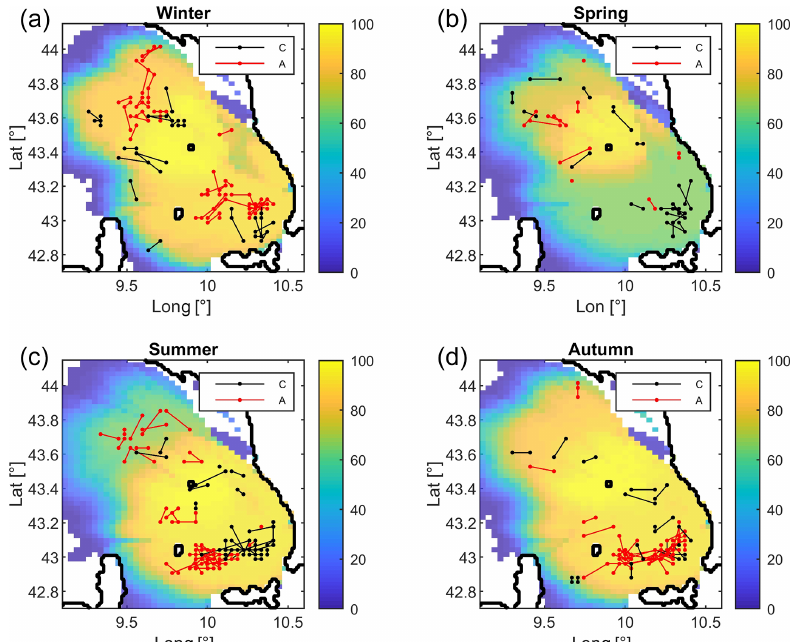
Figure 13. Maps of the area covered by the LaMMA HFR network showing the percentage of HFR data availability during 2019 for (a) winter, (b) spring, (c) summer and (d) autumn. The Tuscany Archipelago (i.e., Elba island) is at the lower right corner of the figures. Tracked cyclonic (black) and anticyclonic (red) eddies detected in each season are